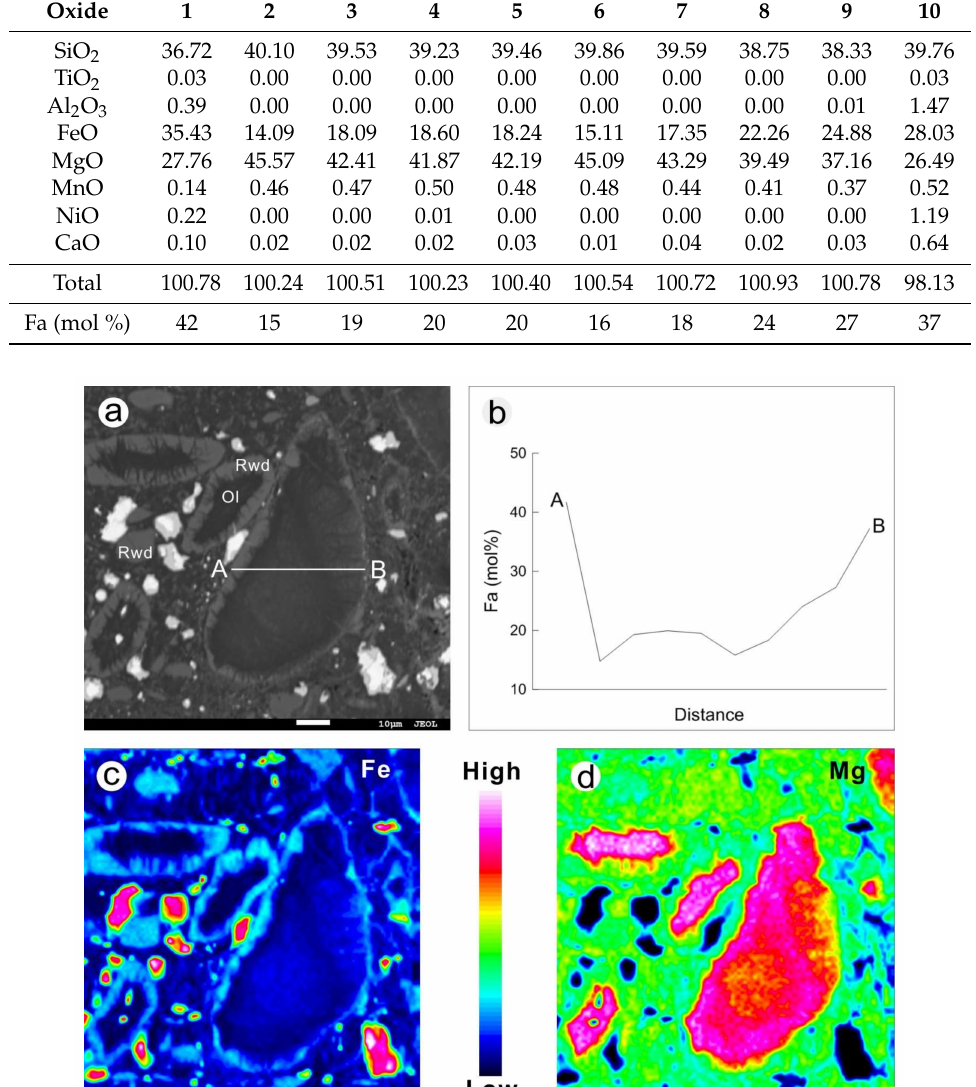
Table 2. Electron microprobe analyses transect of an olivine-ringwoodite clast.